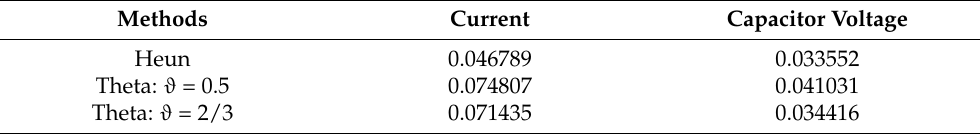
Figure 7. Absolute errors of capacitor voltage in the second branch. Table 1. Maximum absolute errors of the current in the first branch and capacitor voltage in the second